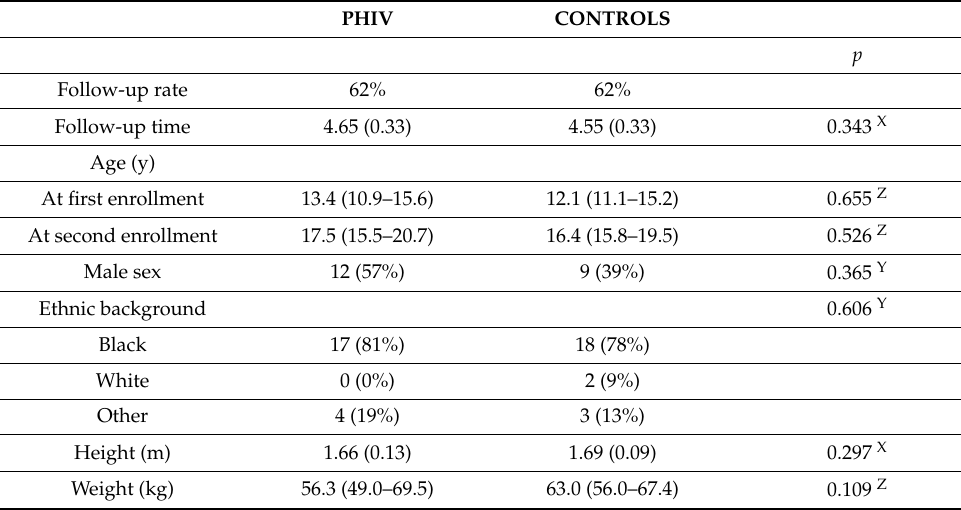
Table 2. Participants’ characteristics of cohort